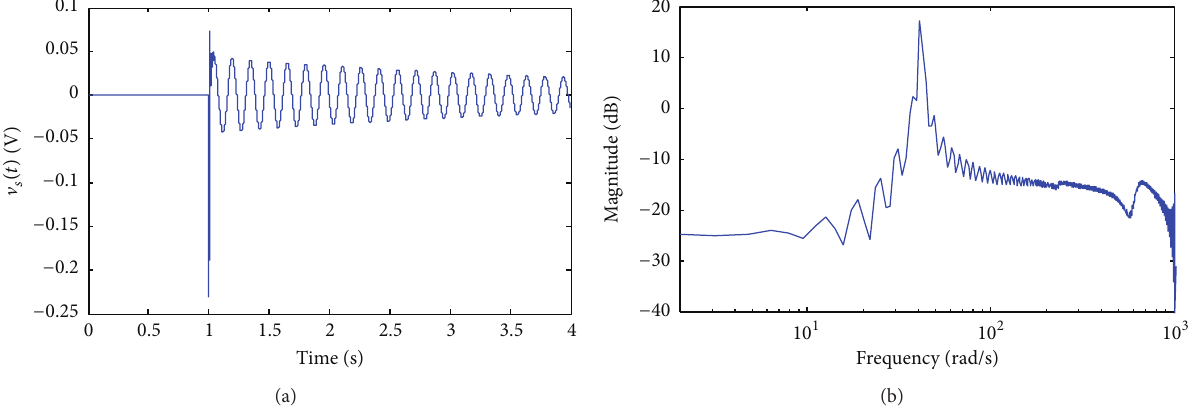
Figure 5: System’s responses based on FE model: (a) pulse response and (b) frequency response function.